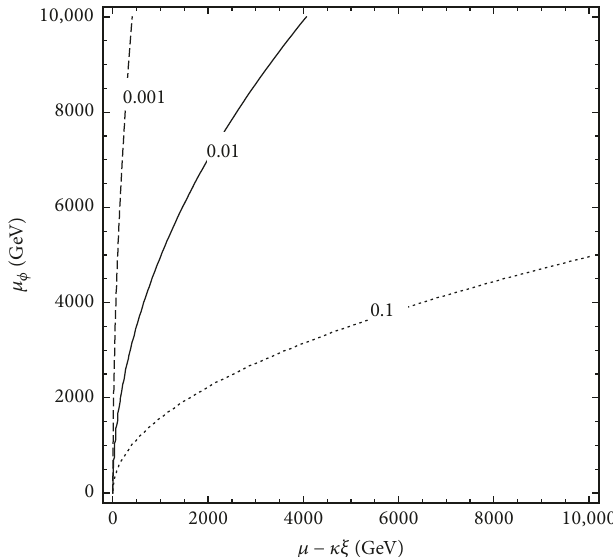
Figure 2: The scalar-Higgs mixing parameter 𝑠 ℎ = 0.001, 0.01, 0.1 contours as a function of the Lagrangian parameters of the